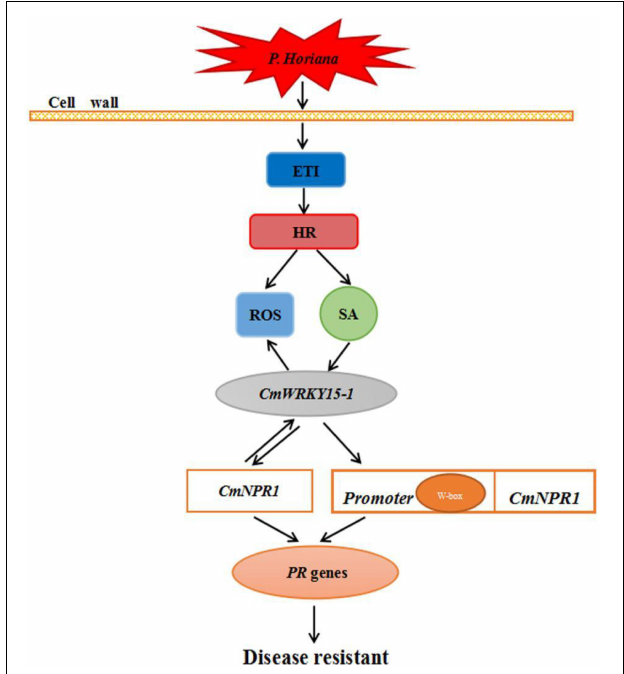
FIGURE 8 | Hypothetical model of the mechanism of ‘C029’ resistance to Puccinia horiana.